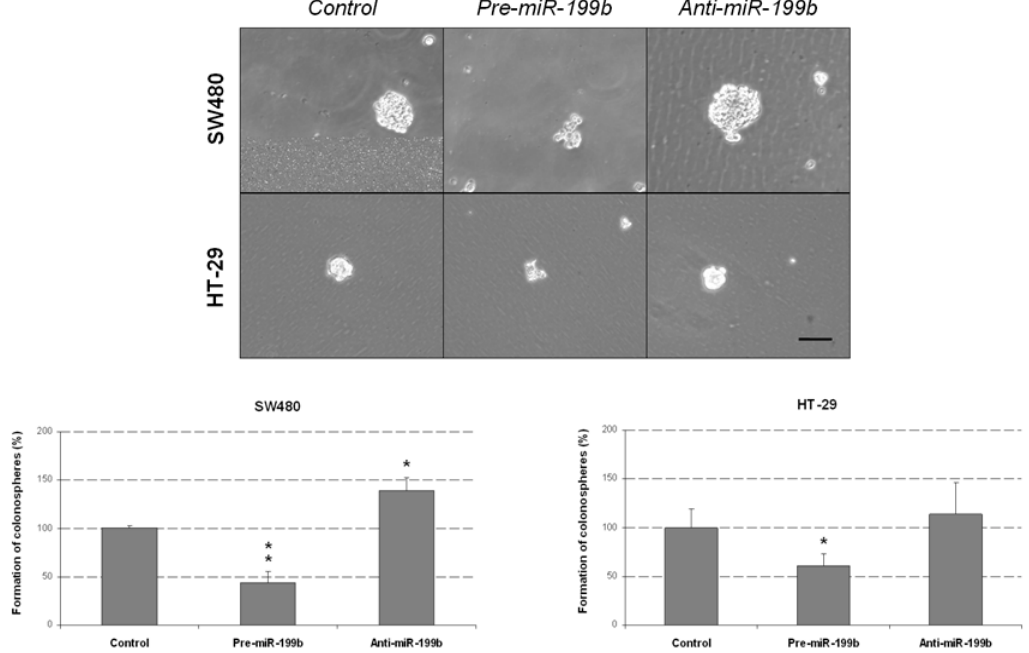
Figure 4. MiR-199b negatively regulates colonosphere formation from CRC cells. Optical microscope images showing the colonospheres formed in the different conditions. The graphs show the number of SW480 and HT-29-derived colonospheres obtained after transfection with pre-miR-199b and anti-miR-199b; * p < 0.05; ** p < 0.01. Scale bar: 200 µ m. Table 1. Association of miR-199b expression with clinical and molecular characteristics in a cohort of 22 liquid biopsies from LARC